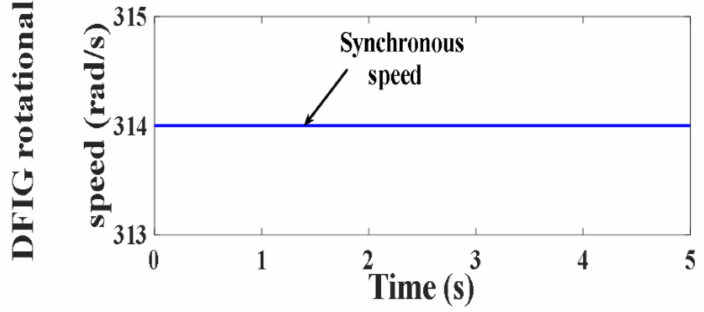
Figure 58. Prime mover operating speed (rad/s).